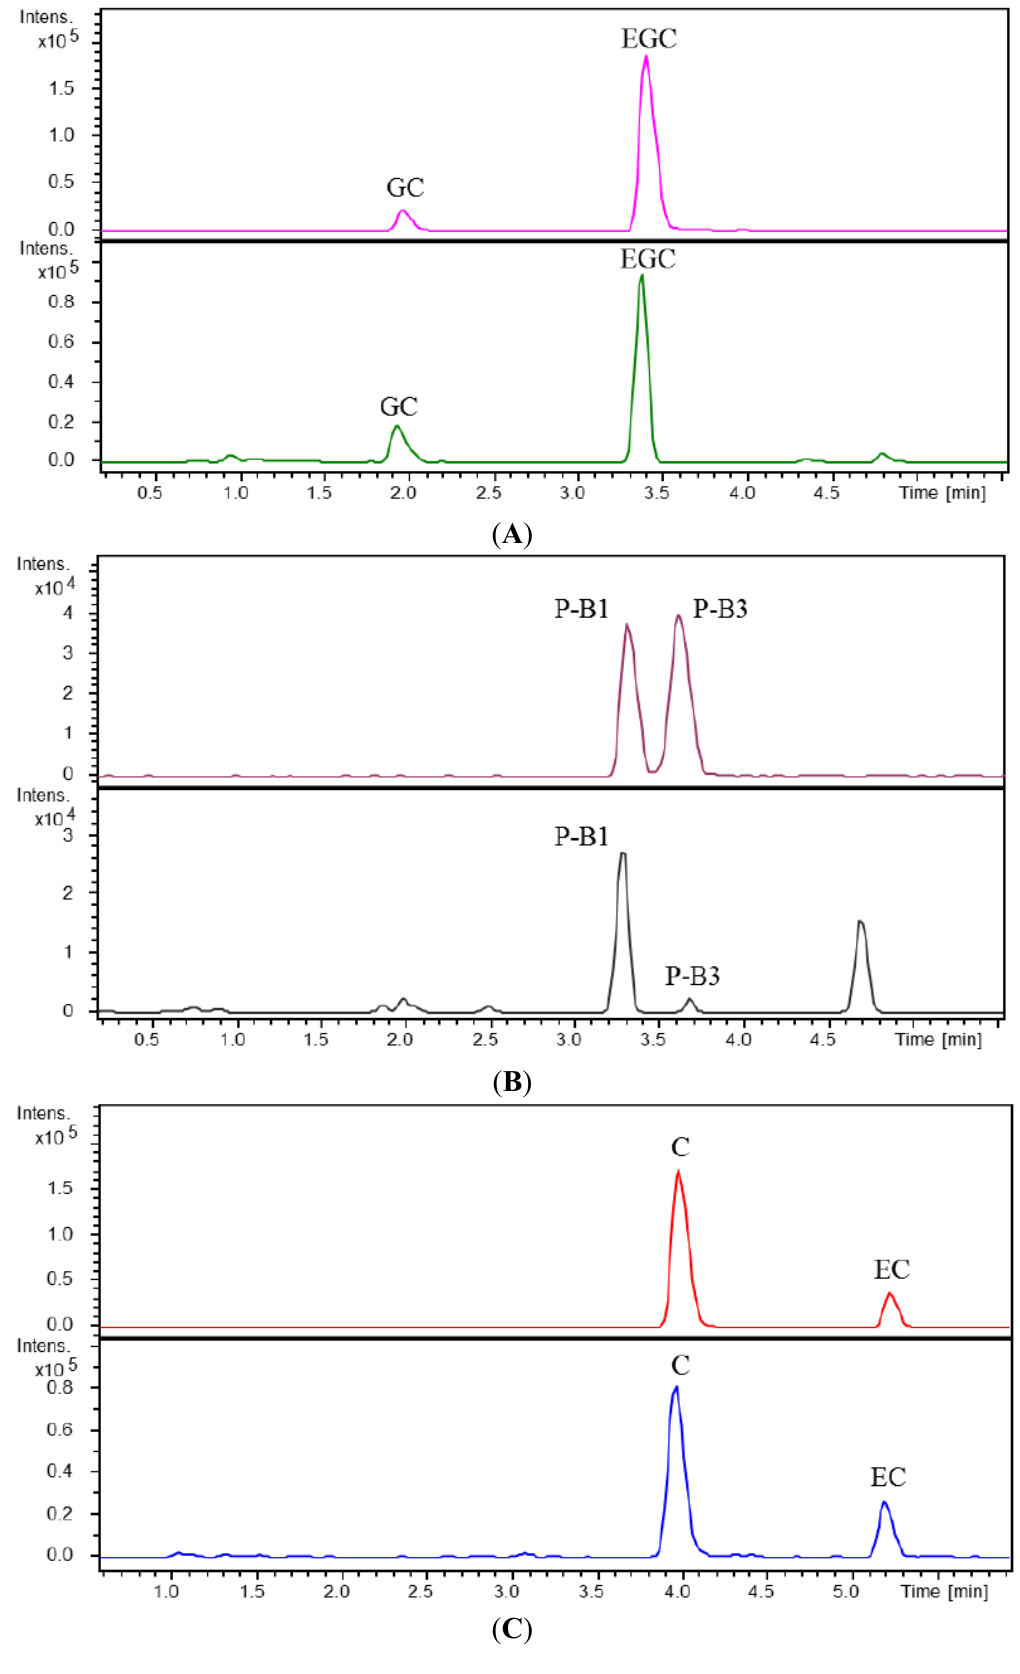
Figure 1. Extracted ion chromatograms (EIC) of GC and EGC ( A ); P-B C and EC ( C ) in mixed standards (upper panel) and in tanakan ® tablets (lower